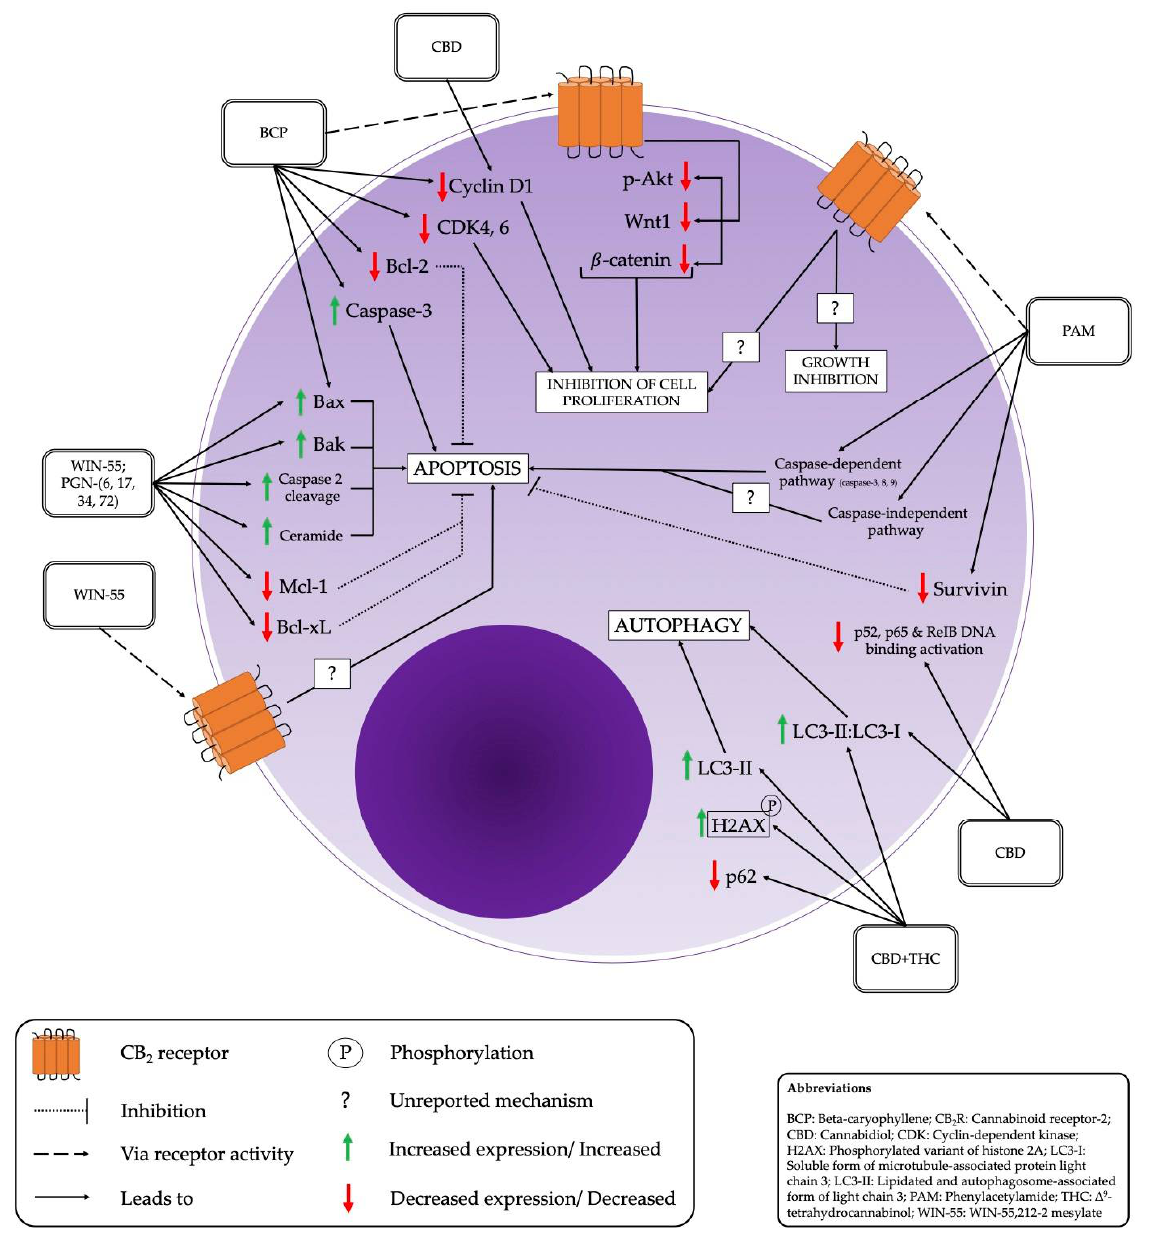
Figure 3. Effects of cannabinoids on multiple myeloma cells and associated pathways.